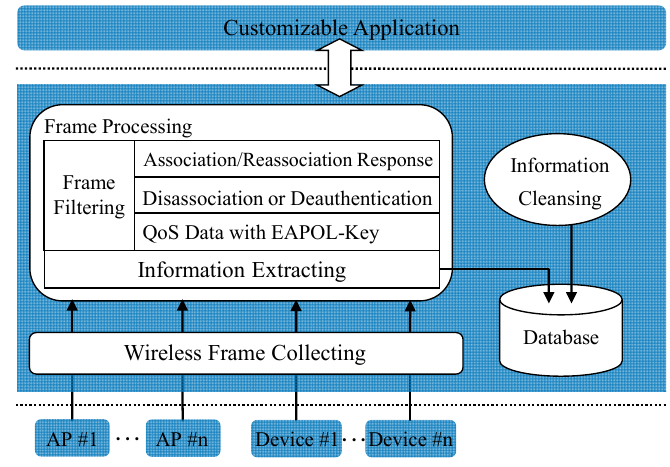
Figure 4. Overview of system architecture.